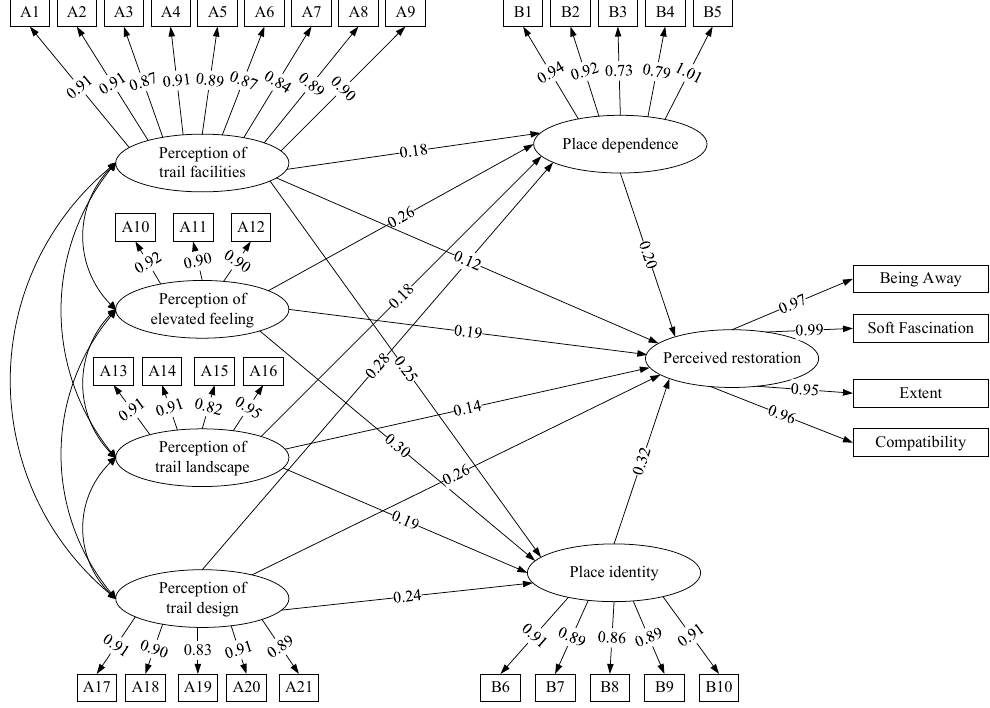
Figure 2. Standard estimates of the Structural Equation Model Path